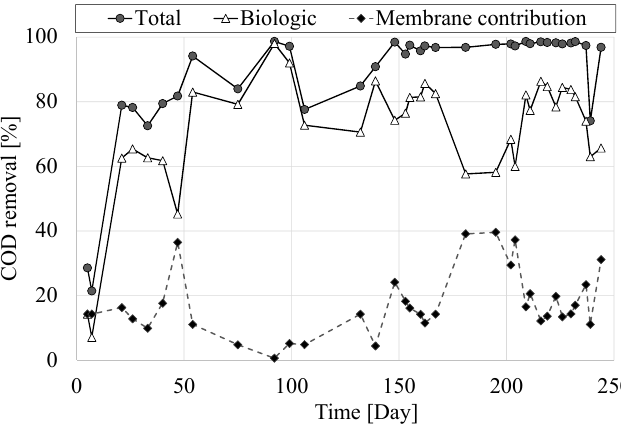
Figure 3. Chemical oxygen demand (COD) removal efficiency throughout experiments.